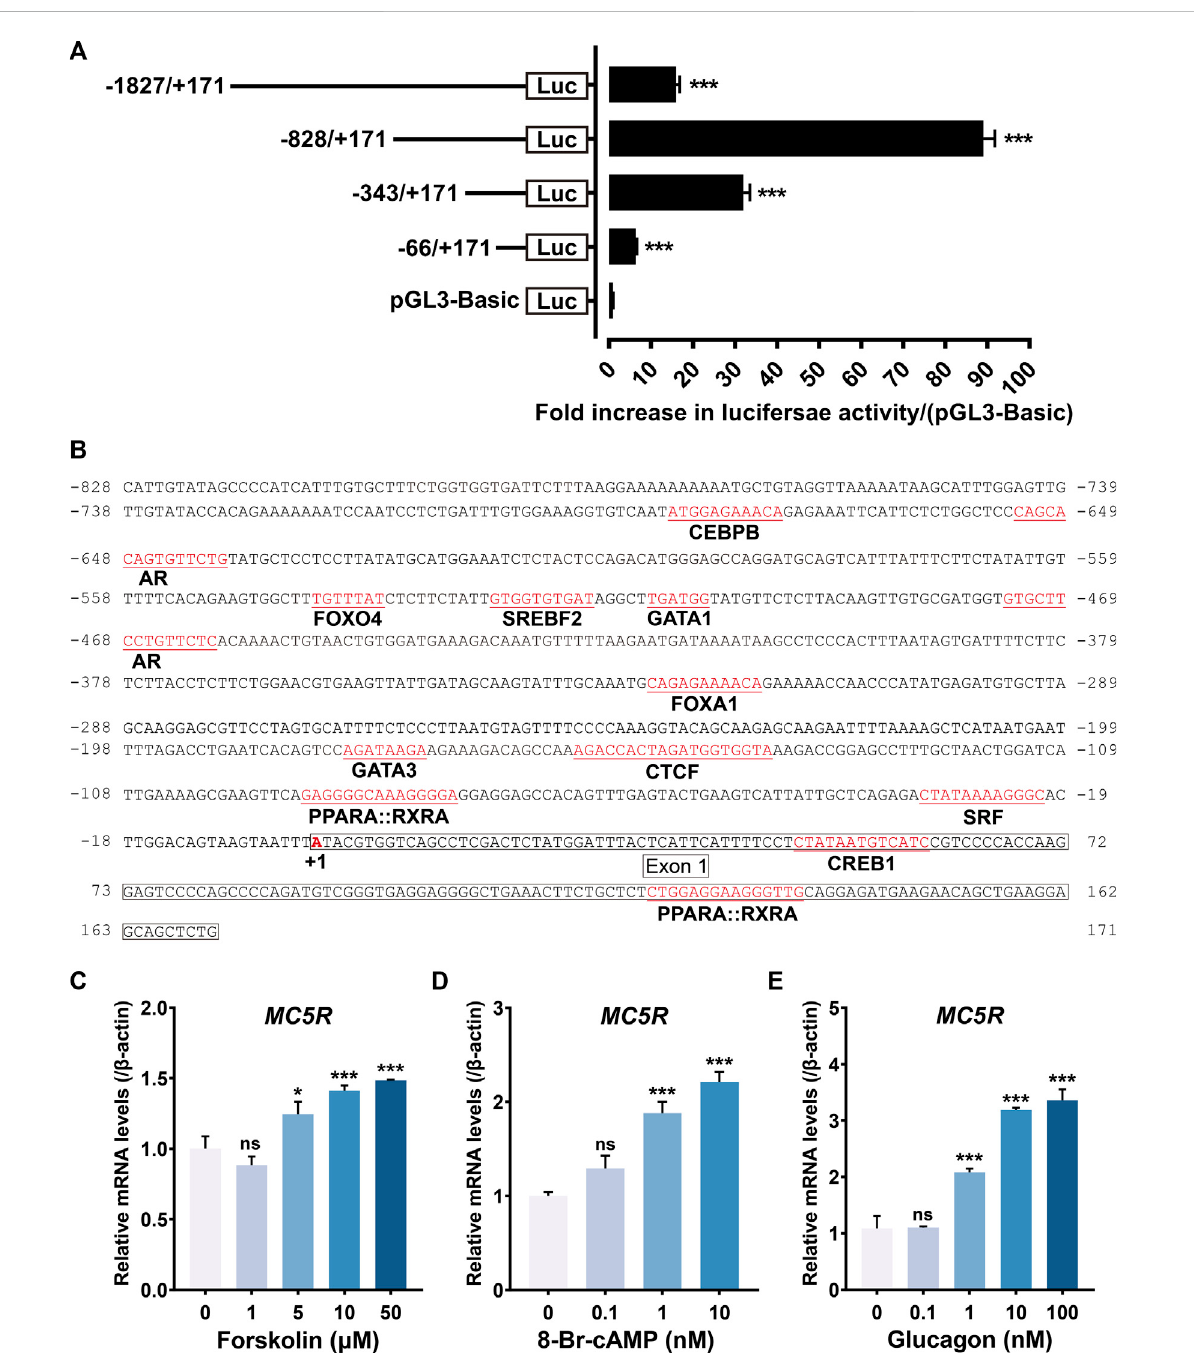
FIGURE 6 (A) Detection of the promoter activities of the 5 ′ - fl anking regions of chicken MC5R gene in cultured DF-1 cells. Various stretches of the 5 ′ - fl anking regions of chicken MC5R were cloned into a pGL3-Basic vector for thegeneration offour promoter-luciferase constructs(P1: − 1827/+171- Luc, P2: − 828/+171-Luc, P3: − 343/+171-Luc, P4: − 66/+171-Luc). Their promoter activities were determined by the Dual-Luciferase Reporter (DLR) assay. All experiments were performed in triplicate and represent at least three independent biological repeats. Data shown represent mean ± SEM. ***, p < 0.001 vs. promoter-less pGL3-Basic vector. (B) Partial sequence (-828/+171) of the chicken MC5R promoter region. The predicted binding sites for transcriptional factors, such as CREB1, SRF, CTCF, AR, FOXA3, FOXA1, and CEBPB were shaded. The transcriptional start site ‘ A ’ was marked with red and designated as ‘ +1 ’ . The sequences of exon 1 was boxed. (C – E) Effects of forskolin (C) , 8-Br-cAMP (D) and chicken glucagon (E) withdifferentconcentrationson MC5R geneexpressionincultured chickenprimaryhepatocytesexamined byRT-qPCR.Eachdatapointrepresents means ± SEM of four replicates ( N = 4). *, p < 0.05, ***, p < 0.001, ns, non-signi fi cant vs. respective control (without peptide